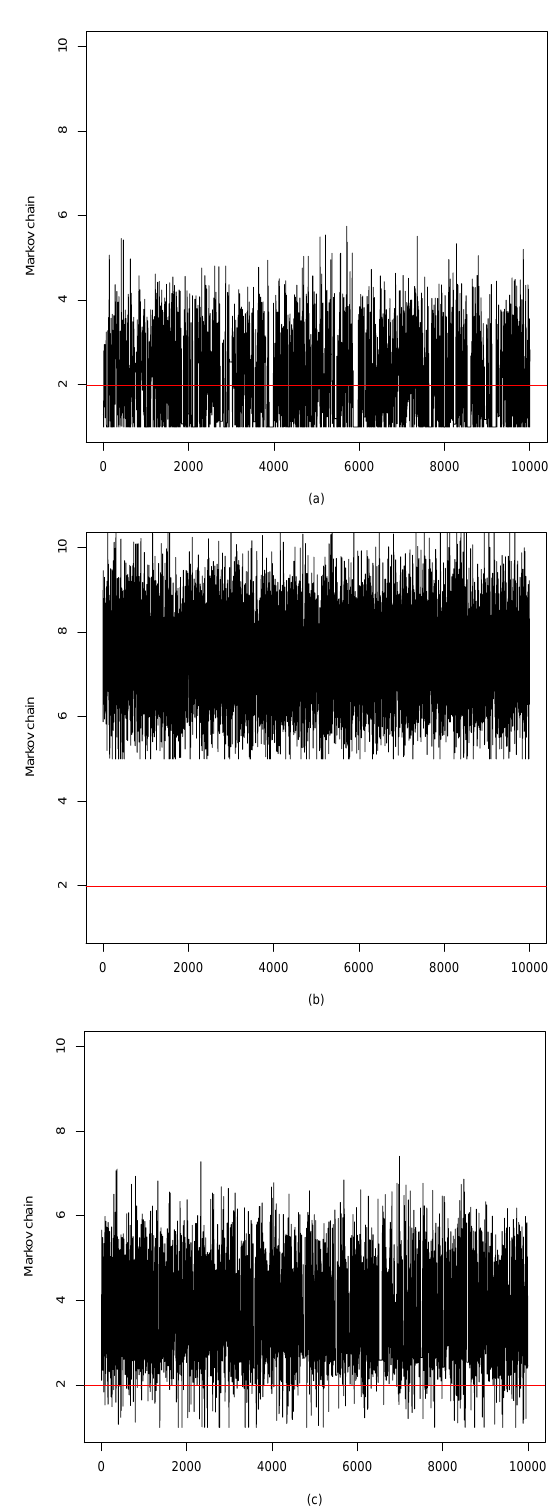
Figure 12. The Markov chain of ˜ c via using ( a ) domain I, ( b ) domain II, and ( c ) domain III: The straight line is the true value of c